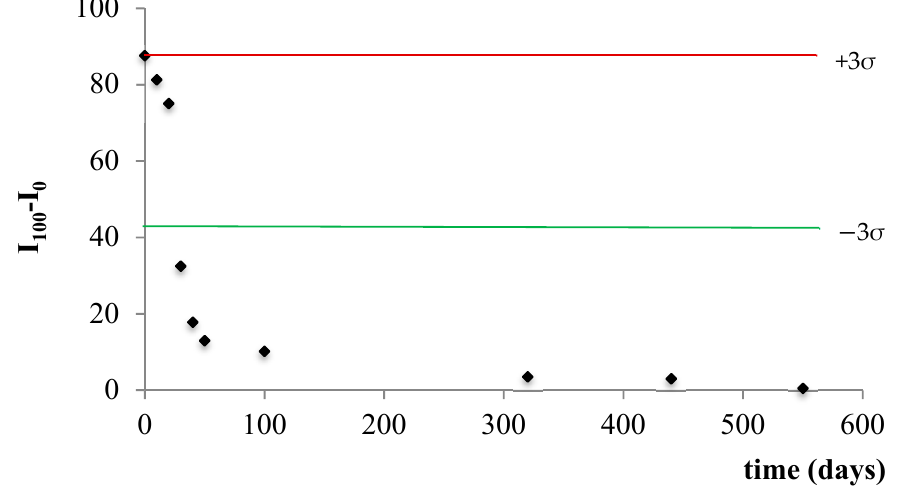
Figure 5. Shewhart control chart for sensing membrane